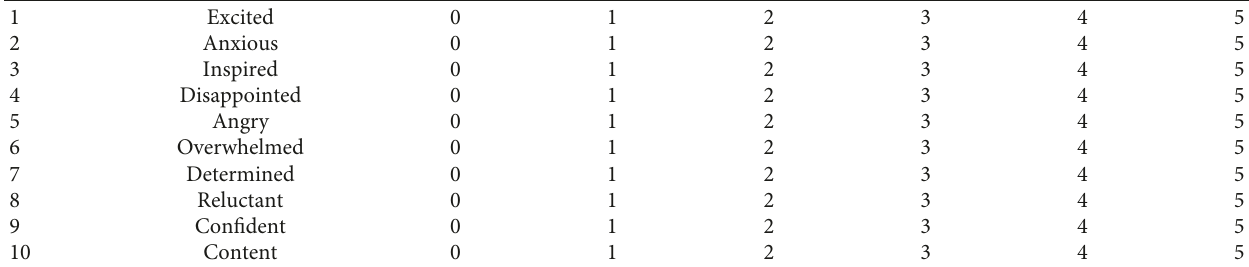
Table 5: Emotions BEFORE attending the program.